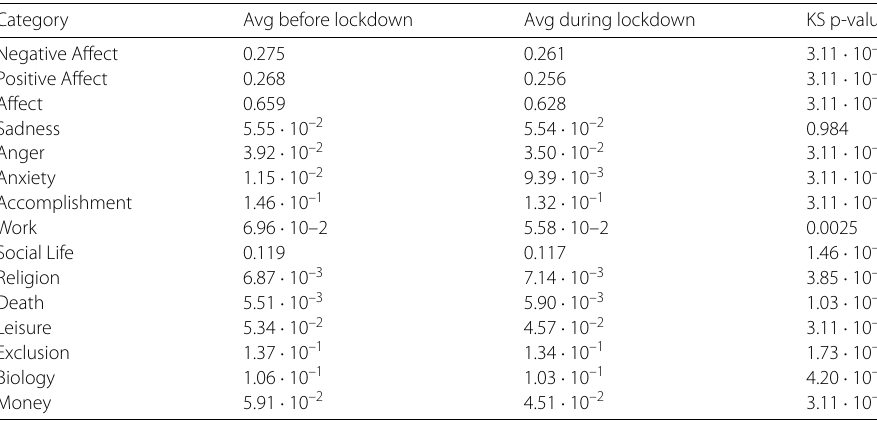
Table 2 p-values of Kolmogorov-Smirnov tests for Twitter content differences displayed by Fig. 6, i.e. content differences before and during the